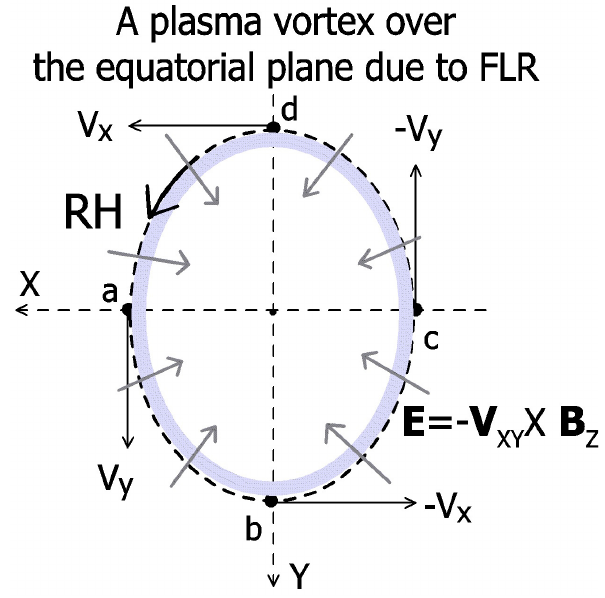
Fig. 4. One plasma vortex (out of ten shown in Fig. 1) is schemati- cally shown as the hodogram of V x and V y taken from Fig. 3. The letters a-d show a velocity vector reorientation in steps of 90 ◦